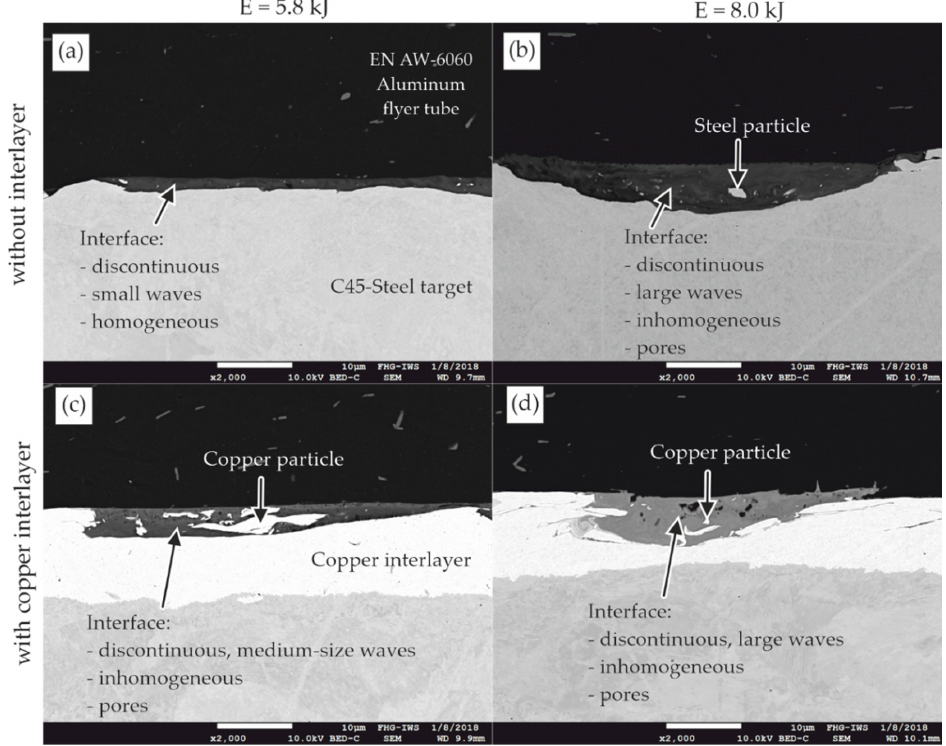
Figure 8. SEM micrographs close to the weld seam end at x = ~4 mm: ( a , b ) without and ( c , d ) with copper interlayer, magnetic pulse welded at two different energy levels. Besides the finding of an increased wave formation at the plastically deformed cop- per interlayer, its effect on the metallurgical composition of the mixed zone was studied by energy dispersive X-ray spectroscopy (EDS). The line scans perpendicular to the weld interface at the end of the weld seam ( x 1 = 4 mm) are plotted in Figure 9. At the lower energy level, the mixed zones between aluminum and steel (a) and copper (c), respec- tively, are very thin. Thus, a roughly linear transition between the two elements is meas- ured and probably reflects the activation volume during EDS measurements. Because the thickness of this zone increases with the higher energy input of 8 kJ, a plateau in the ele- ment distribution can be detected. The ratio is approximately 70 wt% aluminum and 30 wt% iron (b) and copper (d), respectively. Further insights into the formation of the inter- metallic layers would require an analysis on a much higher resolution level such as by means of TEM analysis (e.g., [24]). However, since this study was focused on the influence of the copper interlayer on the overall joint formation, no further nanoscale analyses were carried out.